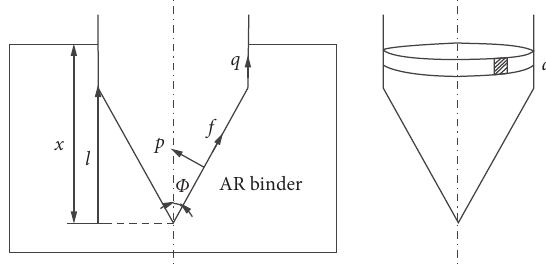
Figure 7: Mechanical analysis of stage